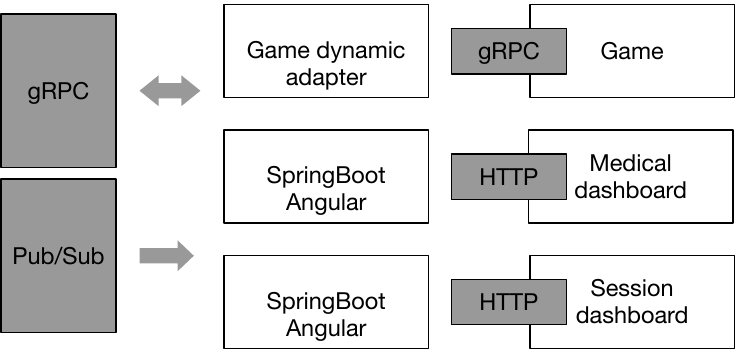
Figure 4. Active